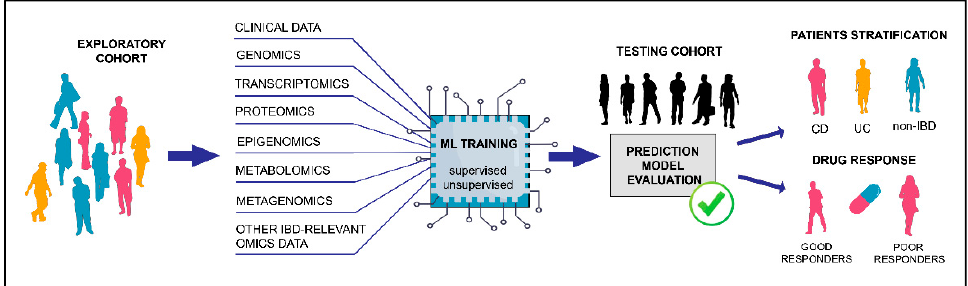
Figure 1. Machine learning using omics data for prediction of clinically relevant IBD outcomes. Om- ics data from patients with known clinical outcomes (exploratory cohort) can be used as input data in machine learning algorithms during the prediction model training. Performance of the designed model is further assessed on an independent group with unknown outcomes (testing cohort). Ma- chine learning models that have high prediction performance on the testing cohort are well fitted and could be employed for future improved patients’ diagnosis, classification, prognosis and pre- diction of drug response. ML—machine learning, CD—Crohn’s disease, UC—ulcerative colitis, and IBD—inflammatory bowel disease. colitis, and IBD—inflammatory bowel